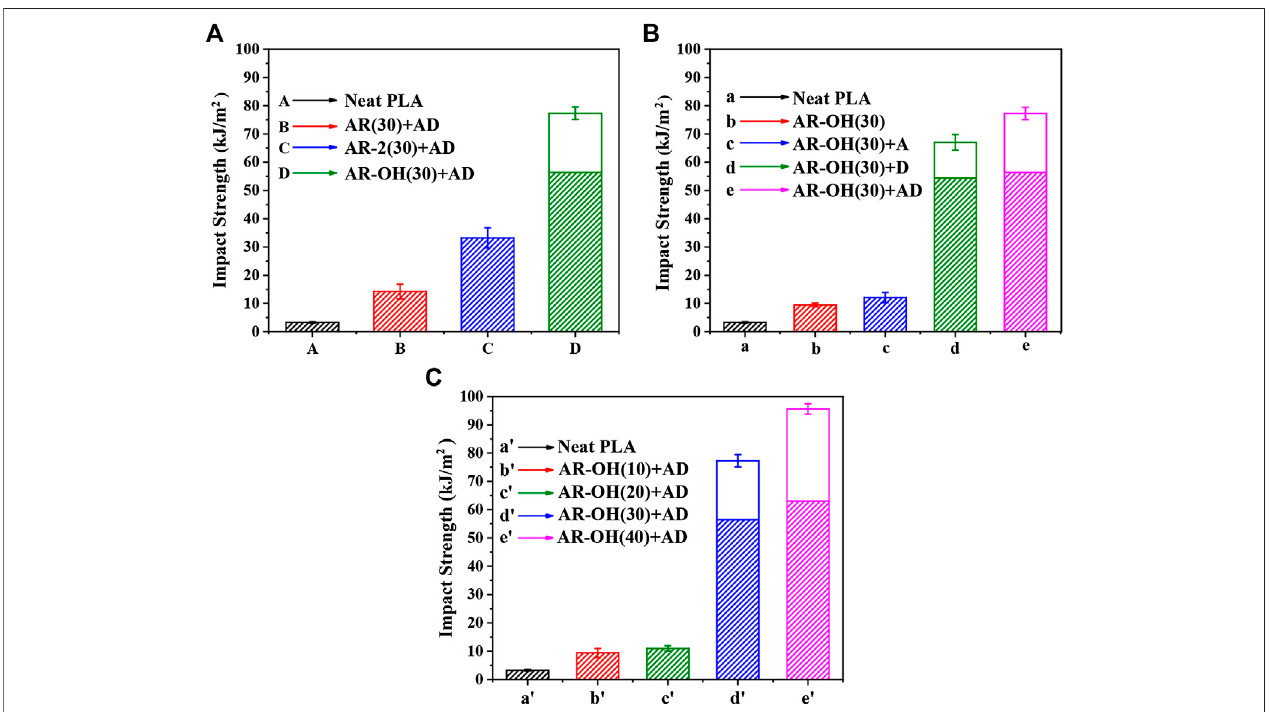
FIGURE 6 | Impact strength of the neat PLA and the PLA/ i -BIIRs blends: (A) neat PLA and PLA/ i -BIIRs blends with ADR and DCP added and 30 wt% content of ionomer, (B) neat PLA and PLA/ i -BIIR-OH blends with different addition of ADR and DCP, (C) neat PLA and PLA/ i -BIIR-OH blends with different ionomer content.